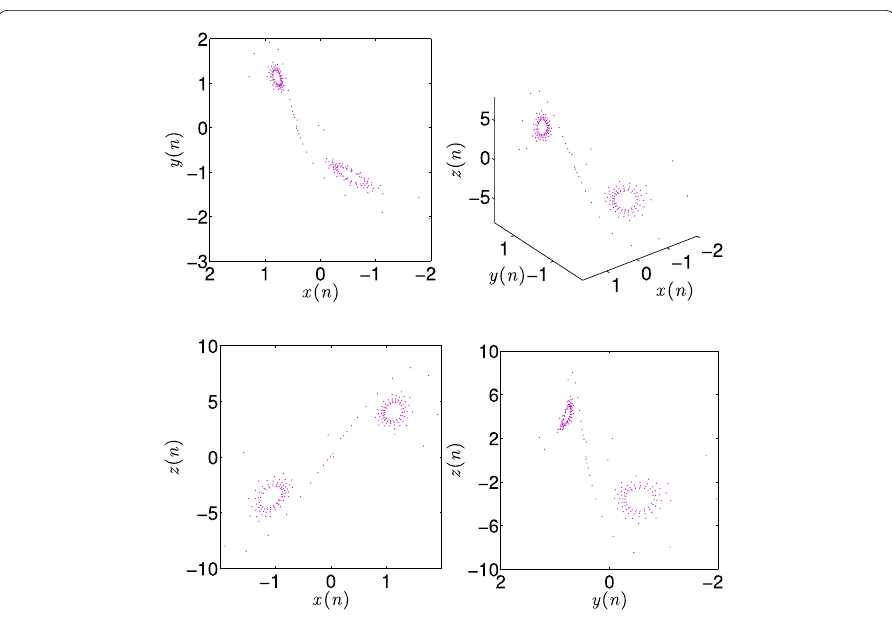
Figure 15 Phase portraits of the standard discrete-time Wang